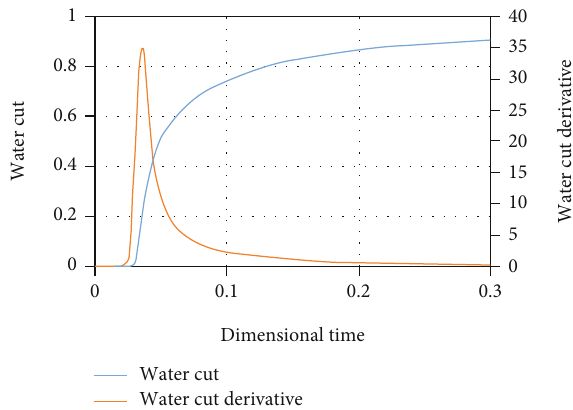
Figure 5: Water cut and its derivative curve with dimensionless time when there is no high-water-consumption zone.